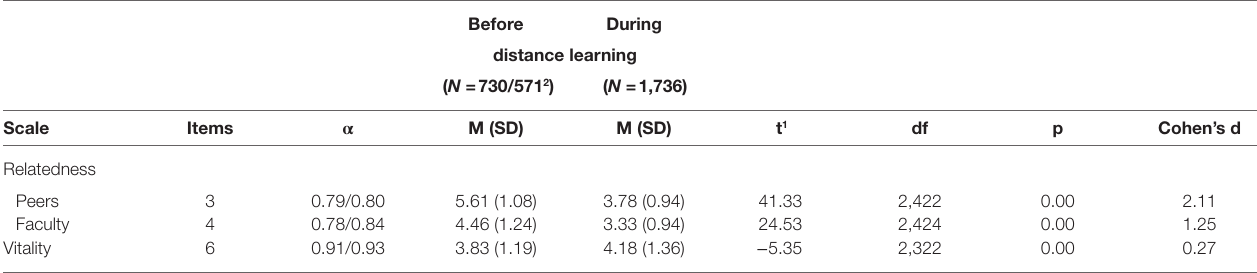
TABLE 3 | Relatedness with peers and with faculty and vitality before and during the distance learning period.